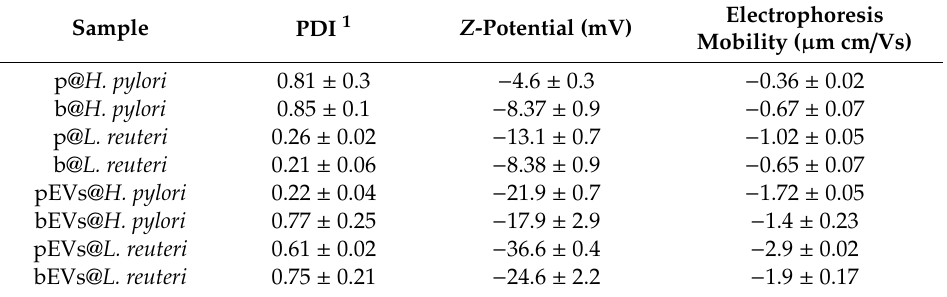
Table1. Physicochemicalcharacterizationofplanktonic(p)andbiofilm(b)supernatantsandMembranes Vesicles (EVs) collected from H. pylori and L. reuteri . Supernatant contains a mixture of bacterial cells and EVs blebbing from H. pylori and L. reuteri respectively. EVs are the isolated forms derived from planktonic and biofilm phenotypes of the two bacterial species. The analysis is the average of ten independent replicates ± standard